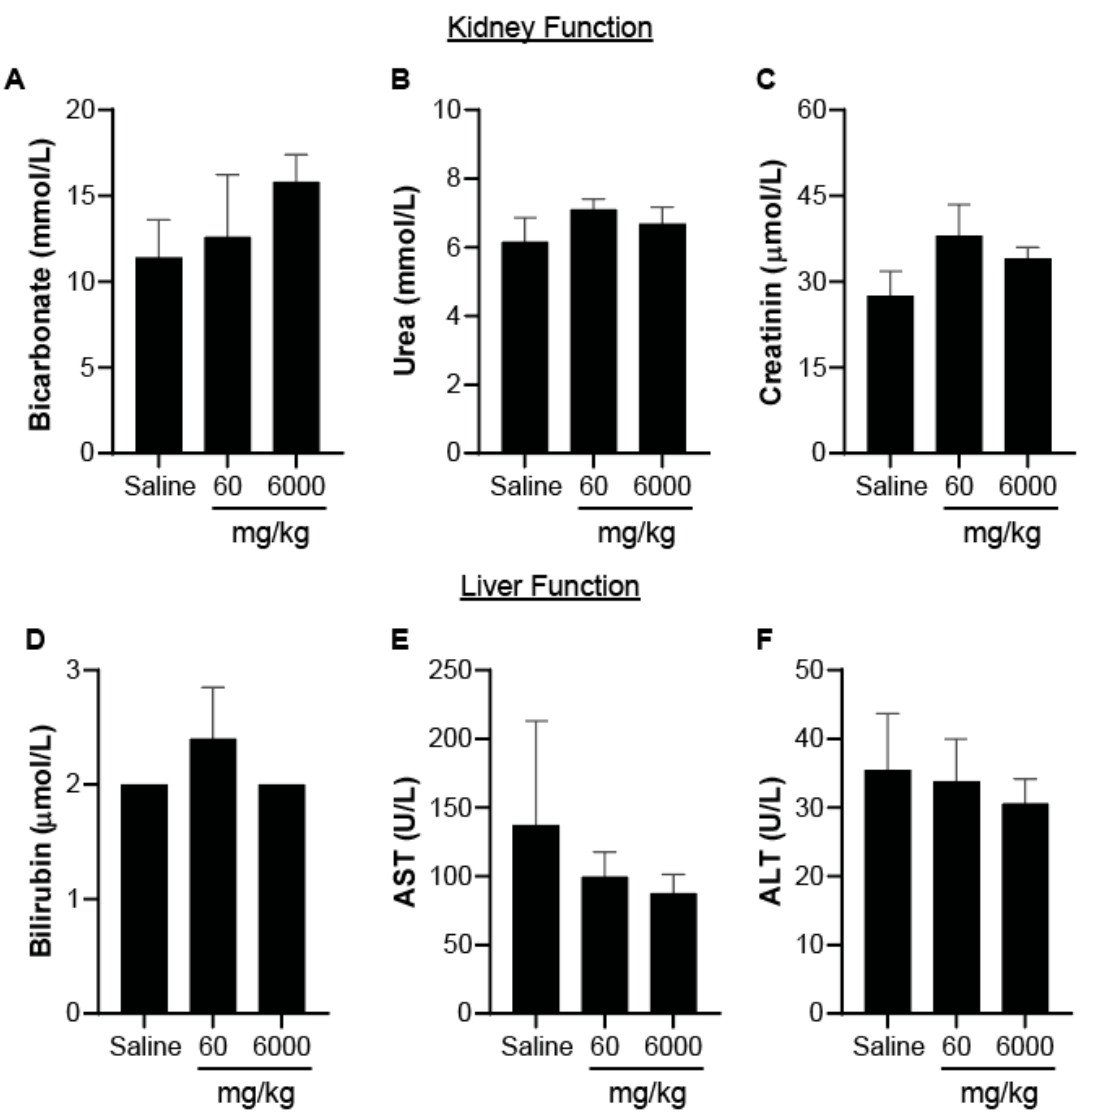
Figure 5. Hematology analysis of the effects of PPNs (acute-dose toxicity) on kidney and liver function. ( A ) Bicarbonate, ( B ) urea, ( C ) creatinine, ( D ) bilirubin, ( E ) AST, and ( F ) ALT levels in mice plasma 14 days after the PPN (60 mg/kg and 6000 mg/kg) or saline injection. The data represent the mean ± SEM of five mice.